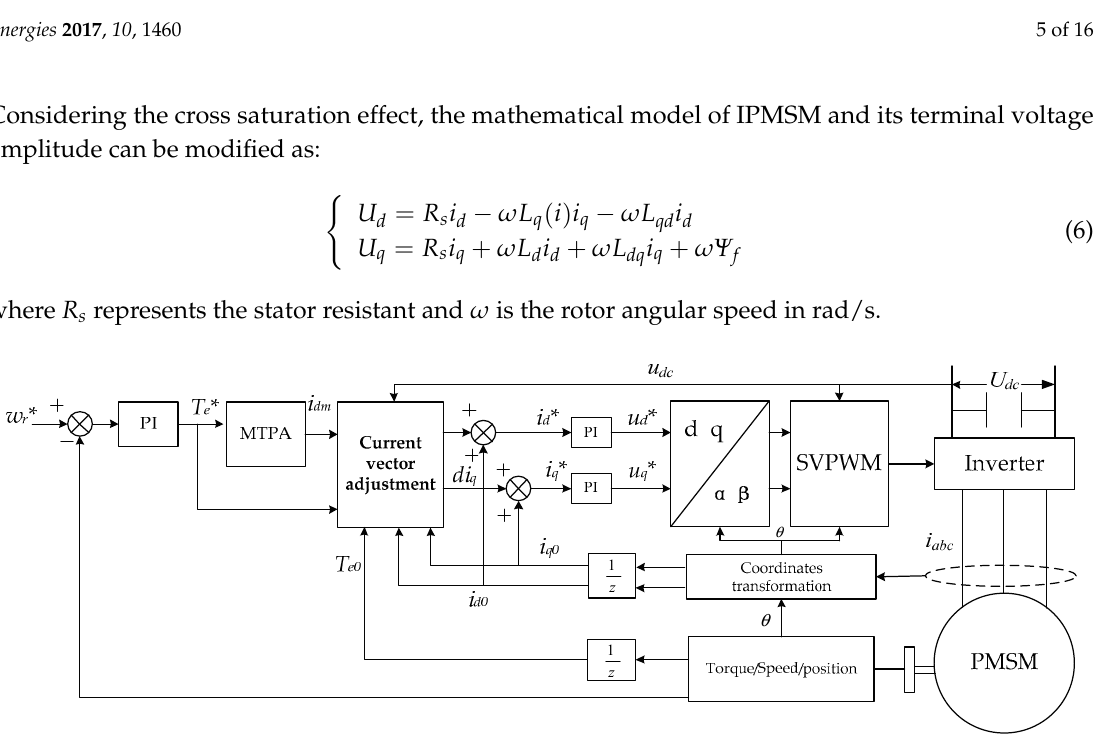
Figure 5. An overview of the current trajectory control strategy.